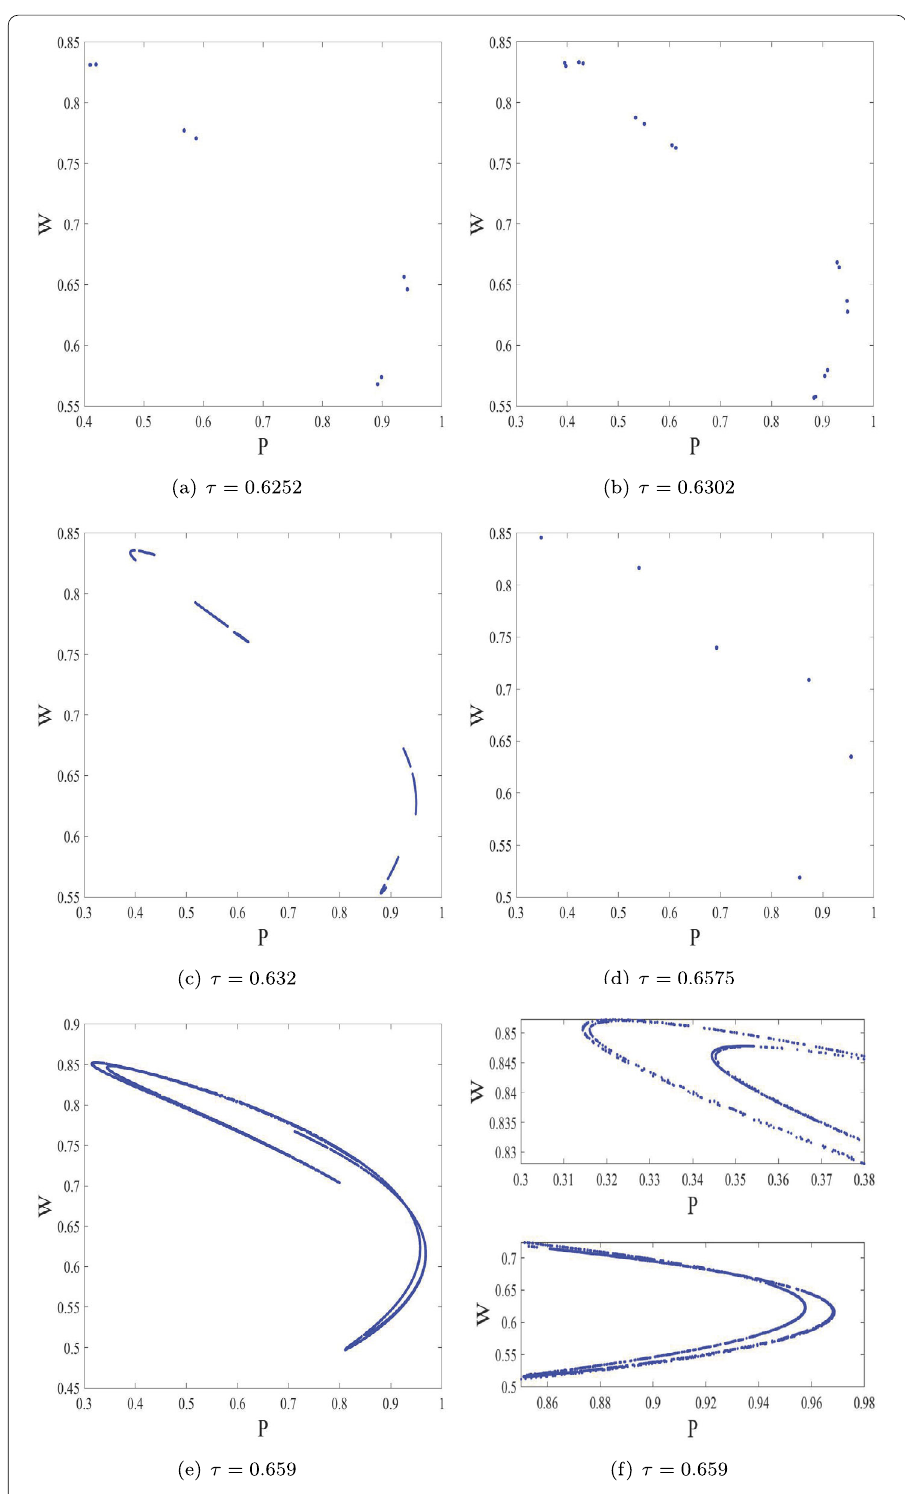
Figure 4 Phase portraits for various values of parameter